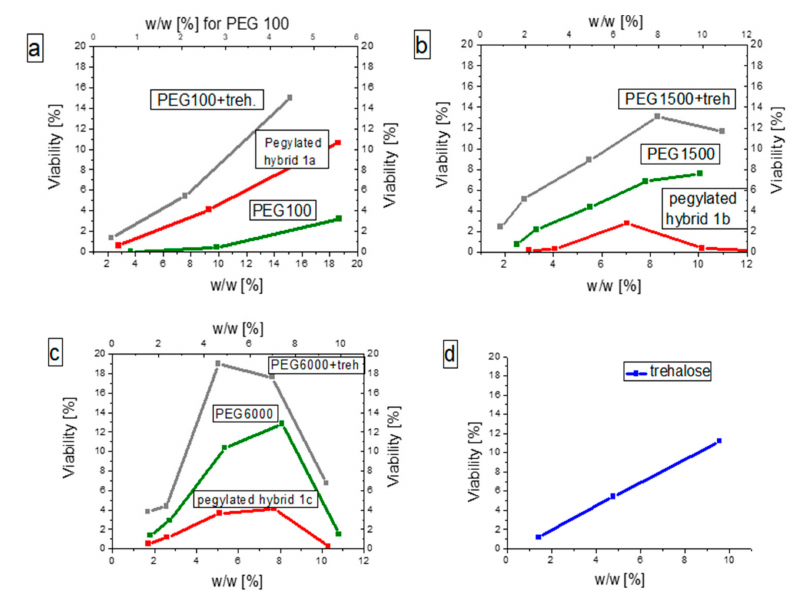
Figure 2. Determination of viability of frozen / thawed human mantle cell lymphoma (Z138-MCL) treated by cryoprotectants at di ff erent concentrations (mass fraction w / w [%]): ( a ) PEG 100, mixtures of PEG 100 and trehalose, pegylated hybrids 1a ; ( b ) PEG 1500, mixtures of PEG 1500 and trehalose, pegylated hybrids 1b ( c ) PEG 6000, mixtures of PEG 6000, trehalose and pegylated hybrids 1c ; ( d ) trehalose. Comparison of cell viability was performed by flow cytometry. For each pegylated hybrid, three distinct controls in corresponding stoichiometric concentrations: trehalose, PEG, mixture of trehalose and PEG. The total amount of cells in the samples was 60,000 ± 4000.